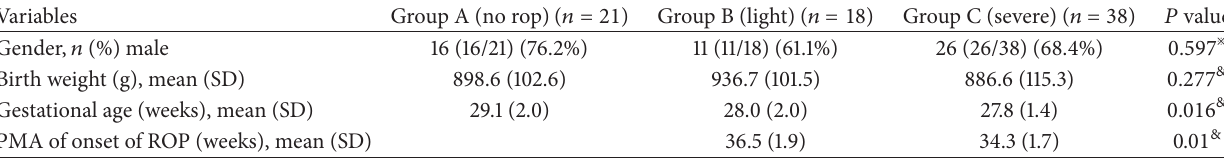
Table 1: Demographics of different group infants with birth weight ≤ 1000